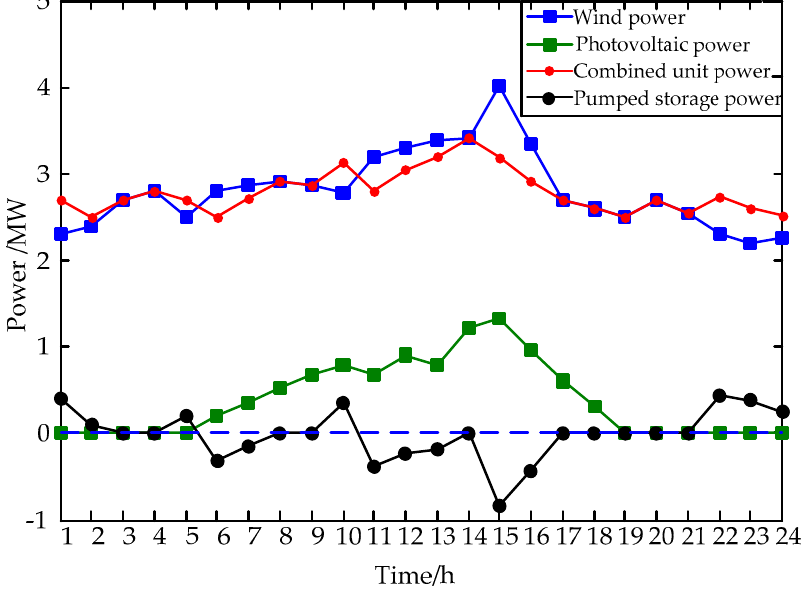
Figure 7. The output curve of each unit after the pumped storage energy flattens on typical day B.